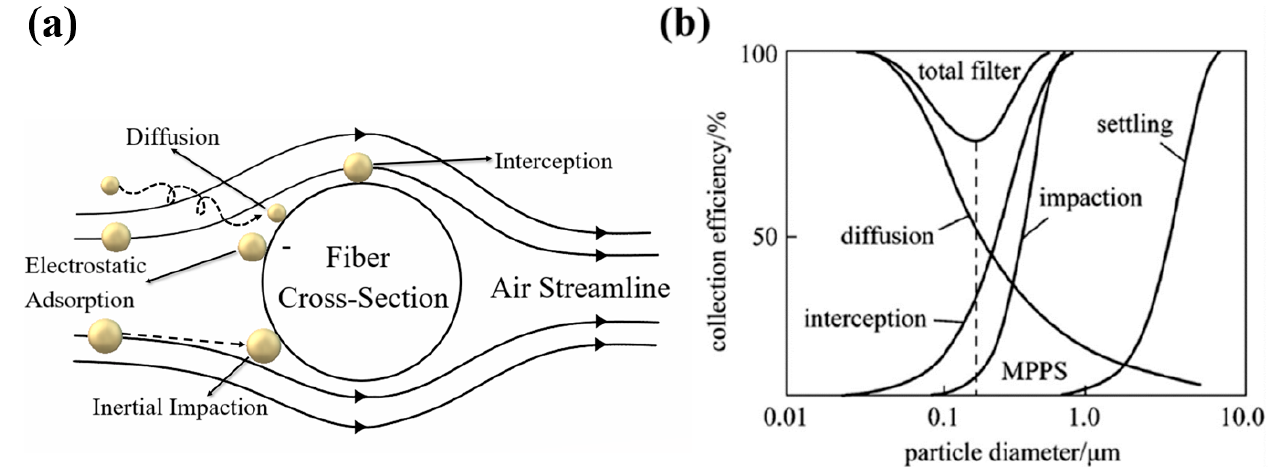
Figure 1. ( a ) Schematic showing of filtration mechanisms. ( b ) Collection efficiency of particles with different diameters [35] .